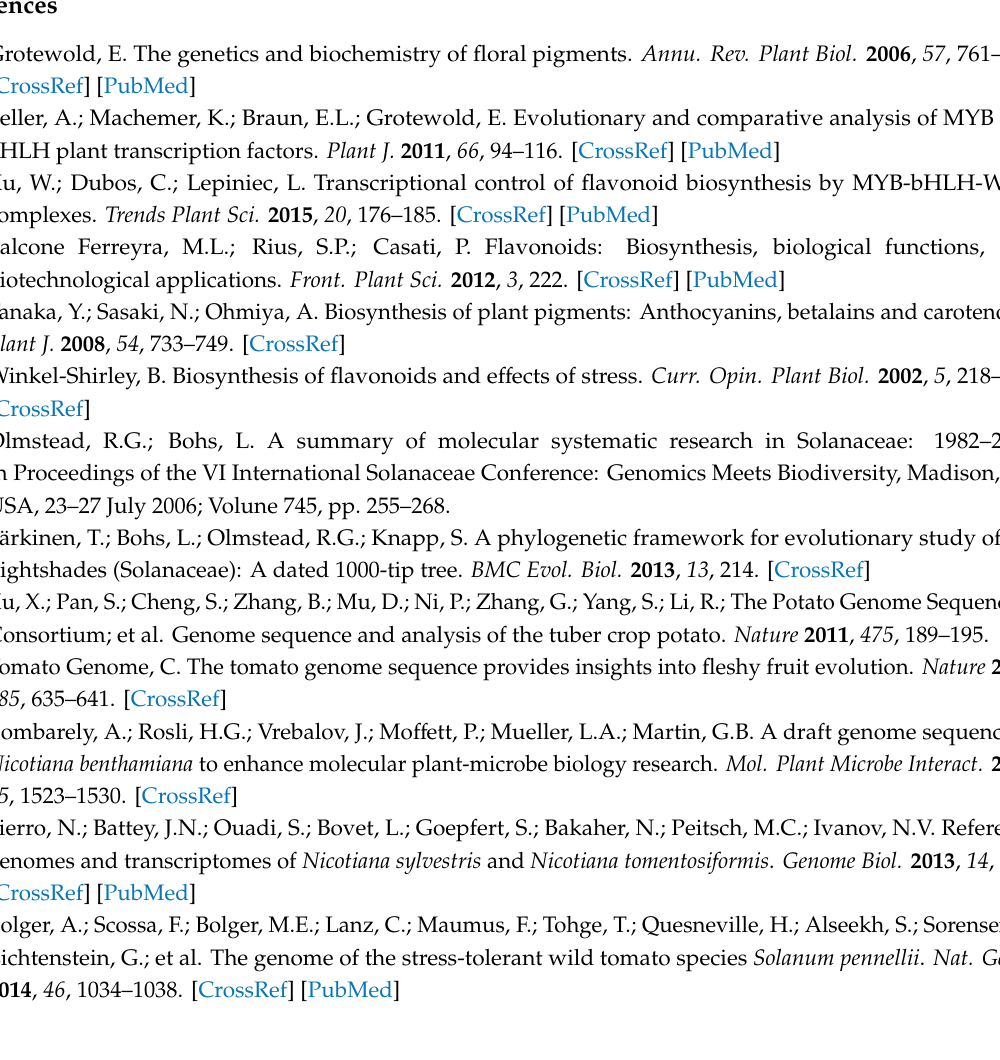
Table S2: Comparison of anthocyanin biosynthesis genes from NCBI and genome-specific